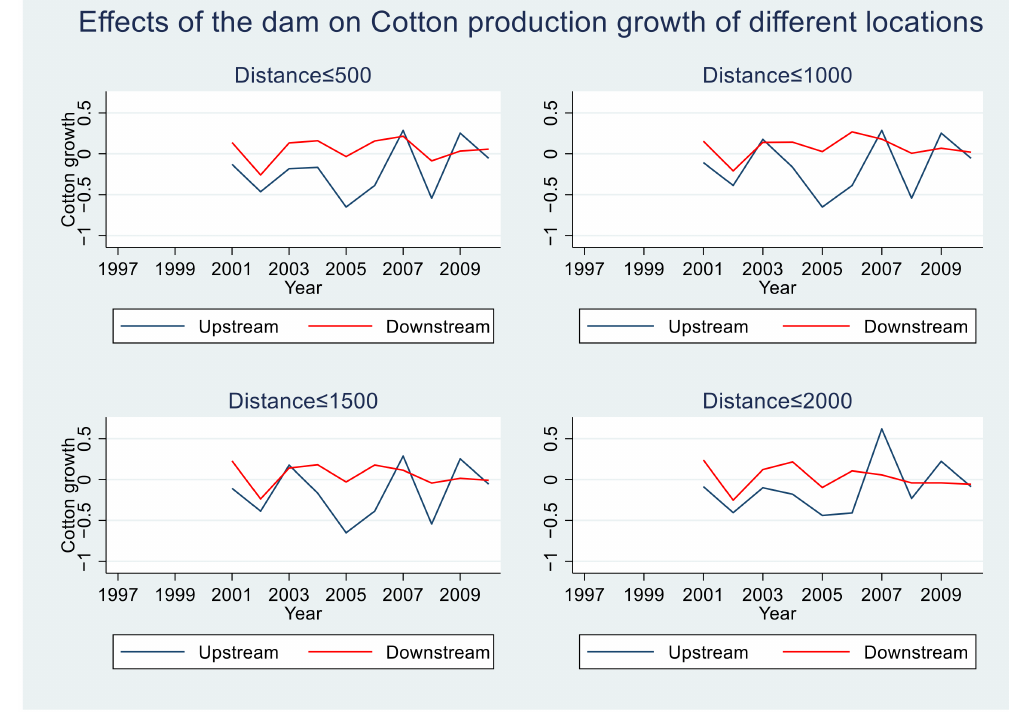
Figure 3. Effects of the damming on the growth rate of cotton production for upstream and down- stream counties. Note: the unit of the distance in each graph is